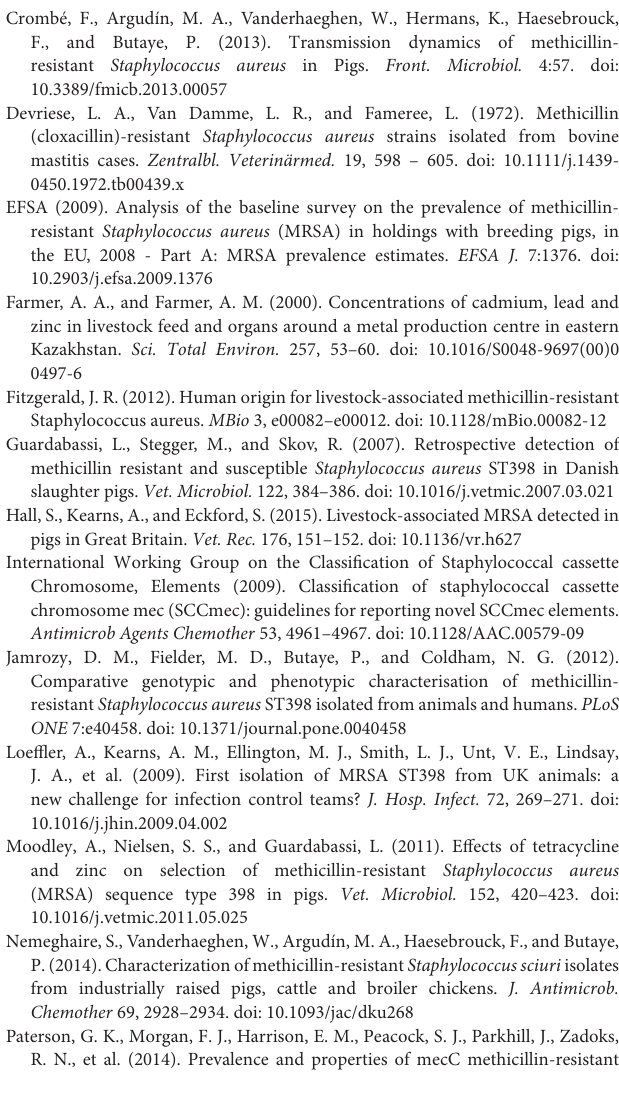
Table S1 | The genotypic and phenotypic characterization of 89 CC398 isolates used in this study, including a reference strain and isolates